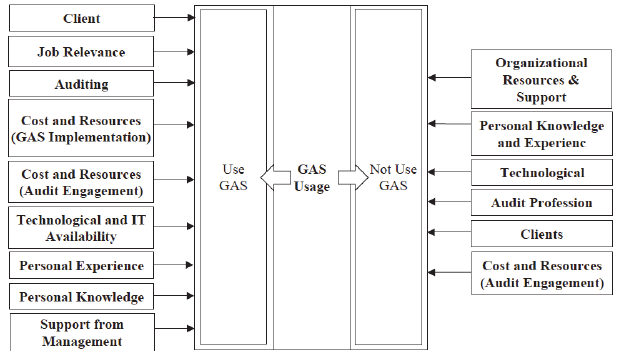
Fig. 1. The structure of the factors influencing on the use of GAS among external authors